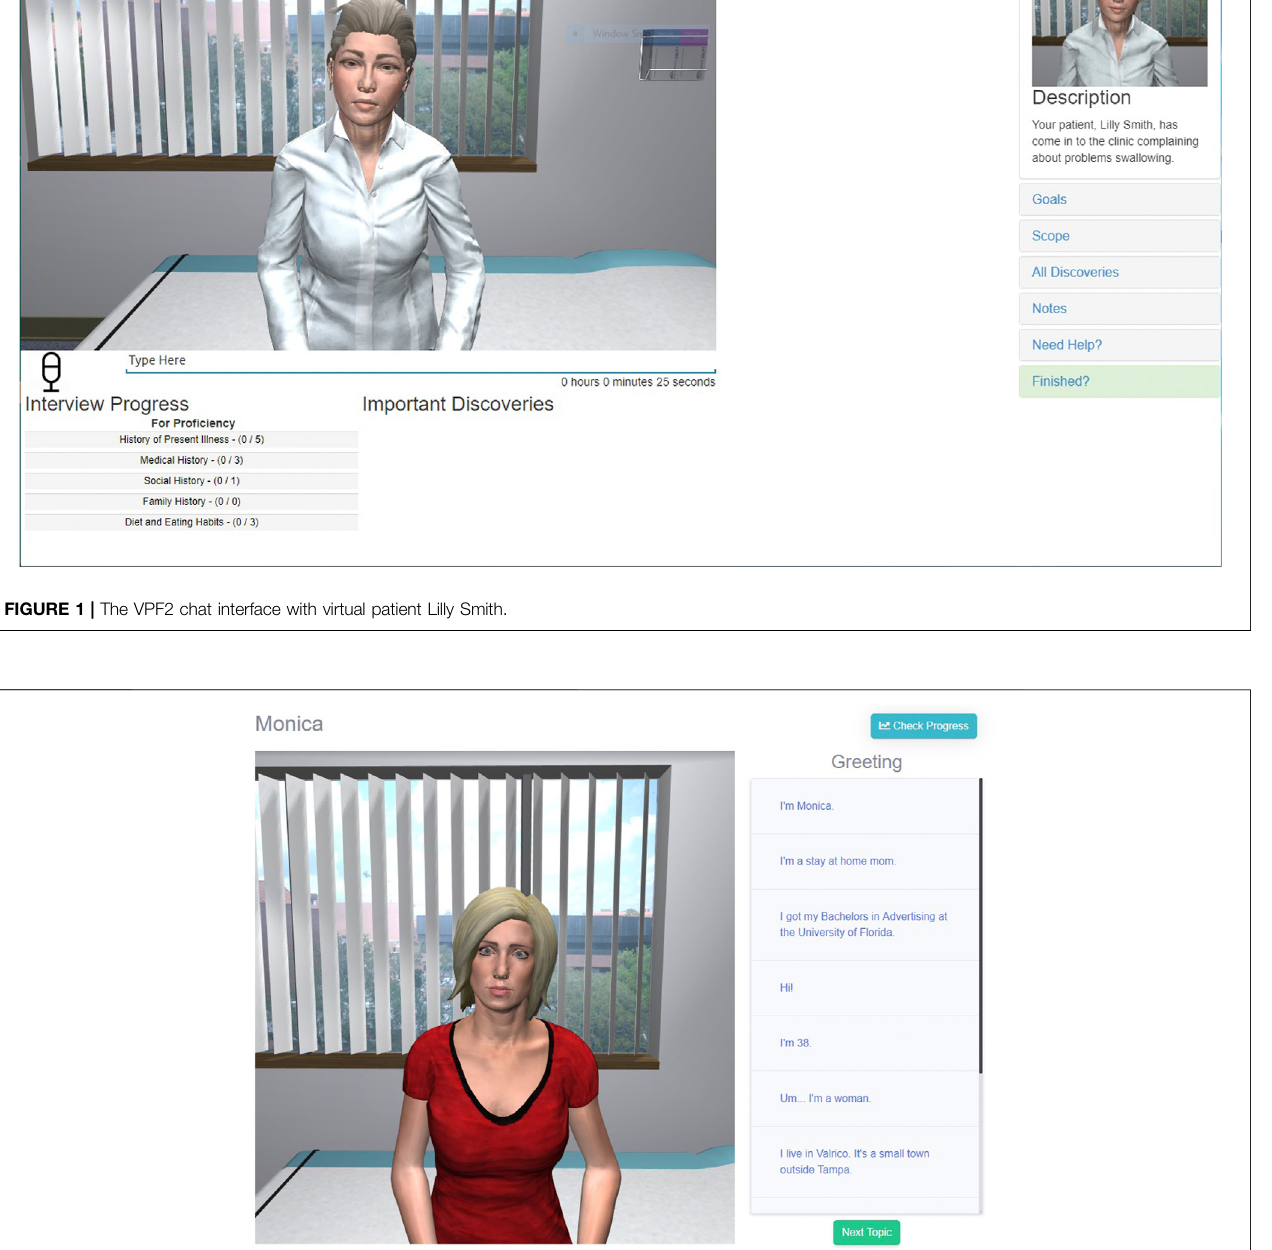
Frontiers in Virtual Reality |